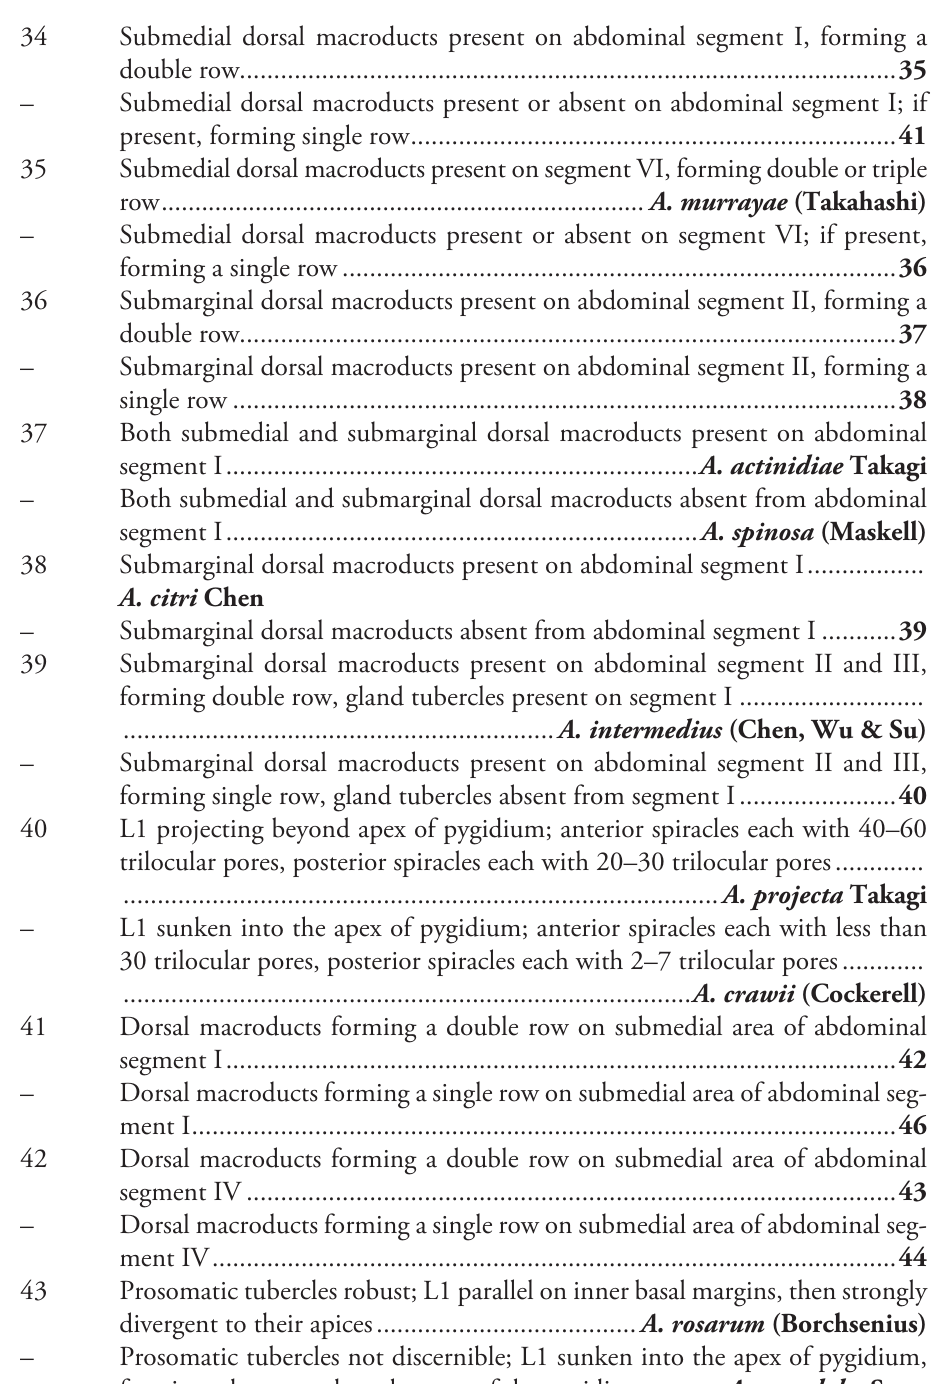
Dorsal macroducts forming a double row on submedial area of abdominal Dorsal macroducts forming a single row on submedial area of abdominal seg- Prosomatic tubercles robust; L1 parallel on inner basal margins, then strongly – Prosomatic tubercles not discernible; L1 sunken into the apex of